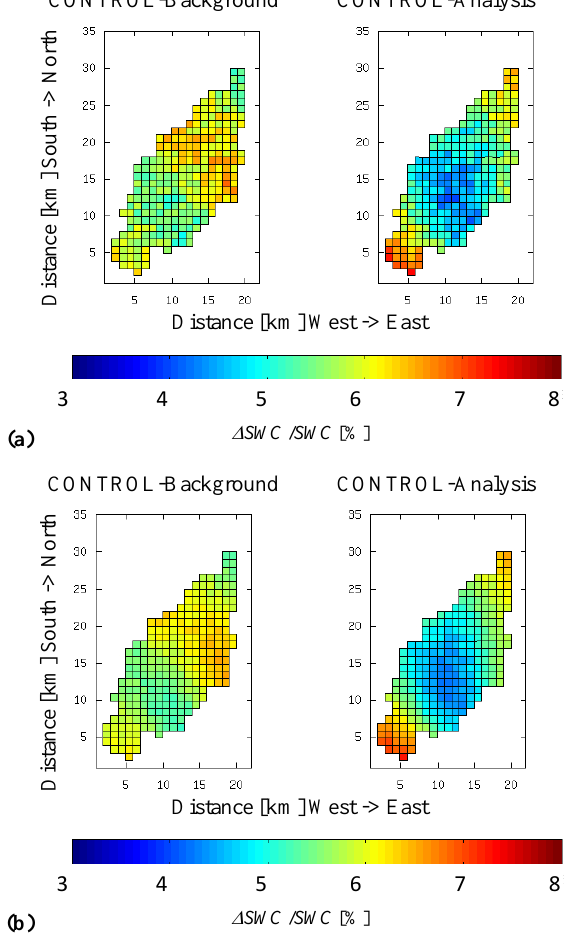
Fig. 11. As Fig. 9, but (a) for the 5th soil layer of TERRA-ML, i.e. 0.27–0.81m depth of the soil, and (b) for the 6th soil layer of TERRA-ML, i.e. 0.81–2.43m depth of the soil.